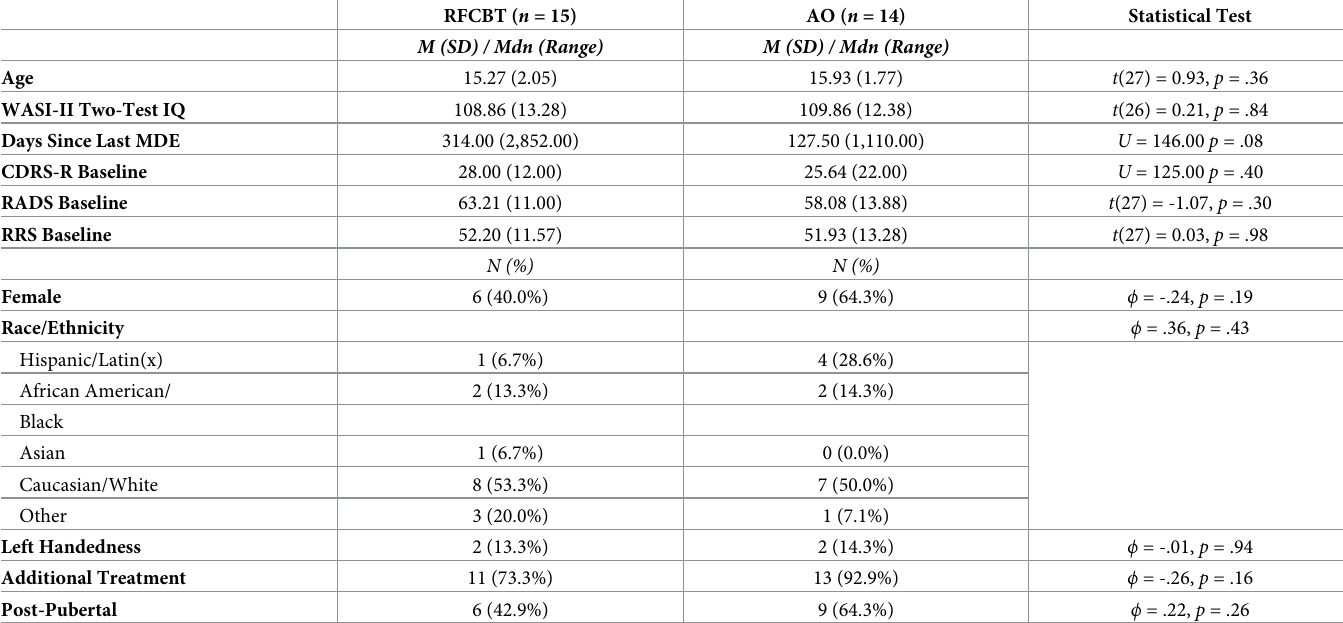
Table 1. Demographics and clinical characteristics of fMRI completer sample (N =